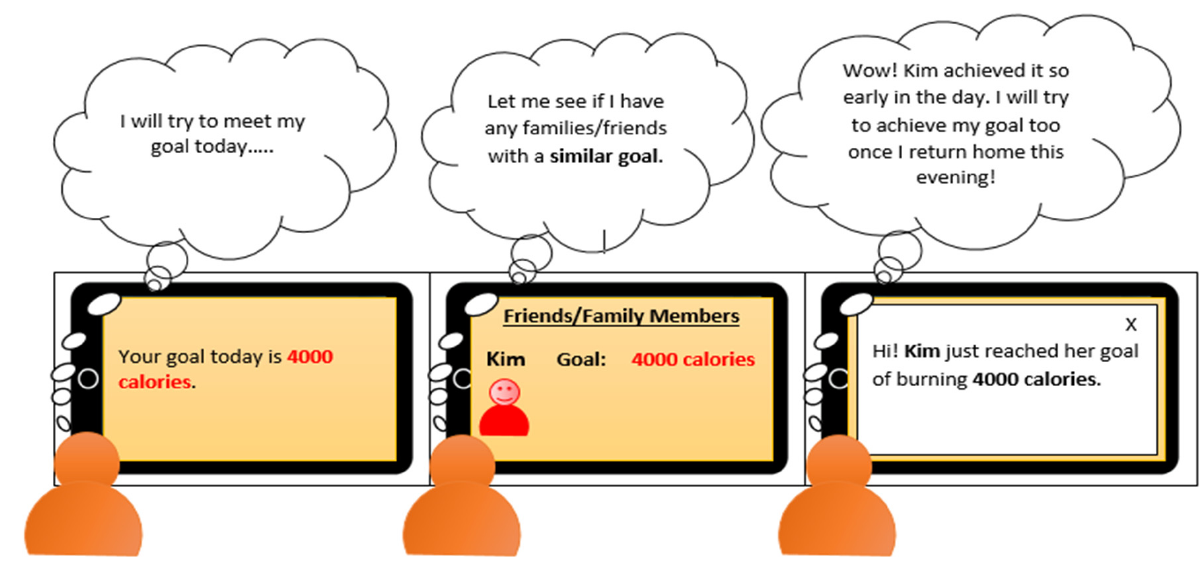
Figure A6. Low-fidelity storyboard illustrating the Social Learning feature of the fitness app [30].